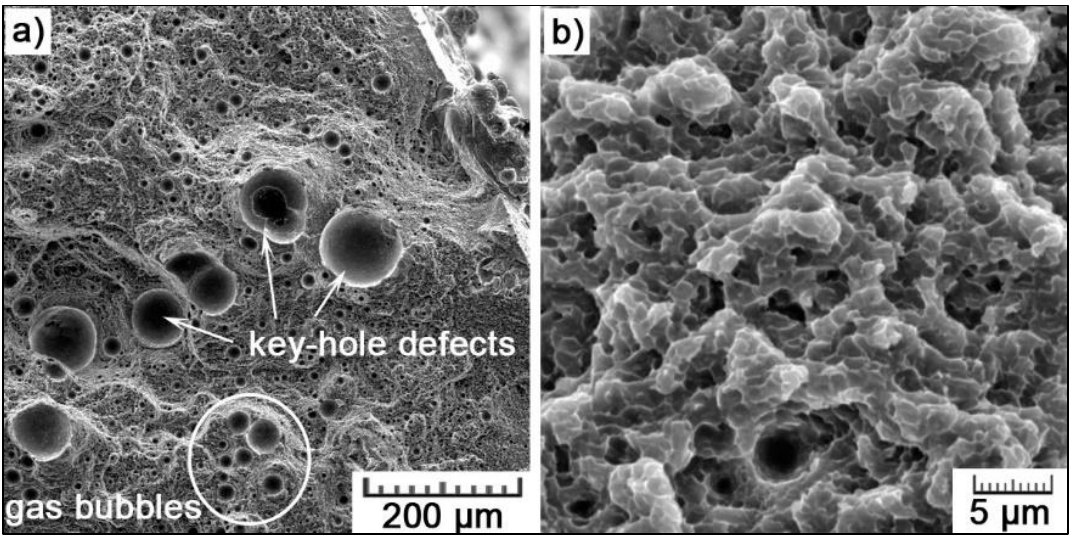
Figure 14. Fracture surface of the SLM AlSi 9 Cu 3 Fe alloy: ( a ) key-hole defects and gas bubbles; and ( b ) fracture morphology.